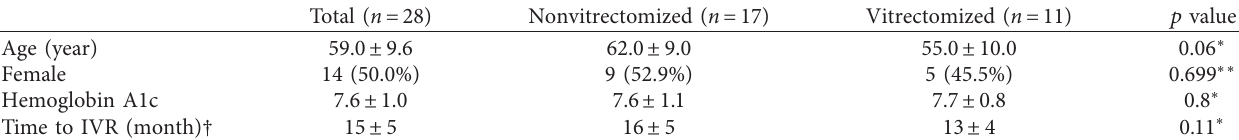
Table 1: Baseline characteristics of the study